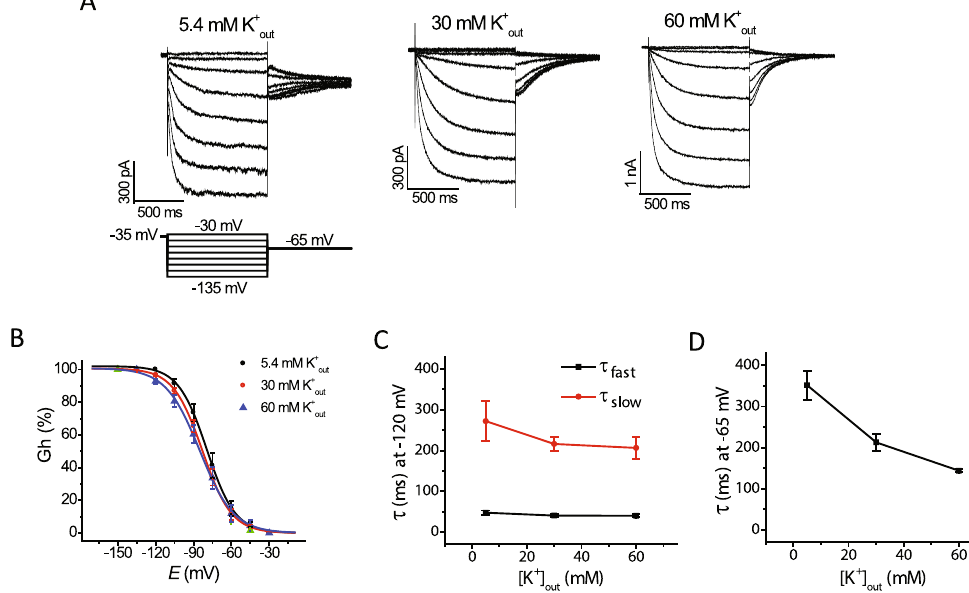
Figure 3. Raising extracellular potassium increases the rate of I h deactivation without significantly affecting the voltage dependence and rate of I h activation. ( A ) Representative traces of I h activated by the voltage protocol shown below the traces at 5.4 mM, 30 mM, and 60 mM potassium in the extracellular recording solution. ( B ) Plots of normalized tail current amplitudes at − 65 mV (G h ) versus test voltage at the three concentrations of extracellular potassium. Curved lines represent fits to a Boltzmann function ( cf . Material and Methods). Mid-activation voltages (V½) are − 79.2 ± 3.6 mV, − 82.2 ± 2.3 mV, and − 84.7 ± 3.9 mV, at 5.4, 30, and 60 mM extracellular potassium, respectively, and were not significantly different (n = 7–11; ANOVA, P = 0.52). The corresponding values for slope factor ( k ) were 9.6 ± 0.5, 10.5 ± 0.7 and 12.4 ± 0.8, and were significantly different (n = 7–11; ANOVA, P = 0.045). ( C ) Plots of fast ( τ fast ) and slow ( τ slow ) time constants of activation of steady-state I h measured at − 120 mV as a function of extracellular potassium concentration. The values obtained at different potassium concentrations were not significantly different (n = 7–11; ANOVA, P = 0.42 ( τ fast ), P = 0.3 ( τ slow )). ( D ) Plot of time constants of I h deactivation as a function of the extracellular potassium concentration. The values of time constants of I h deactivation was significantly different between values obtained at 5.4 mM, 30 mM and 60 mM extracellular potassium (n = 5–11; ANOVA, P <